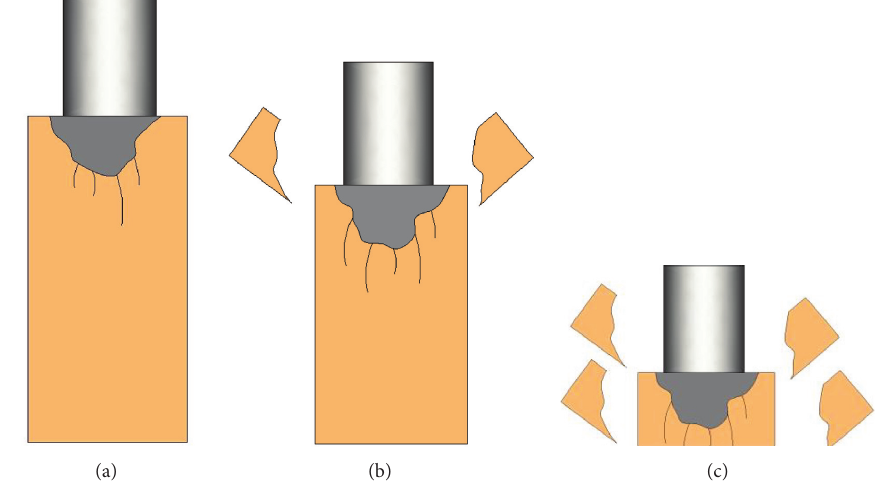
Figure 10: Illustration of progressive failure in rock during the test. (a) Broken starting. (b) In the broken. (c) Completely broken.